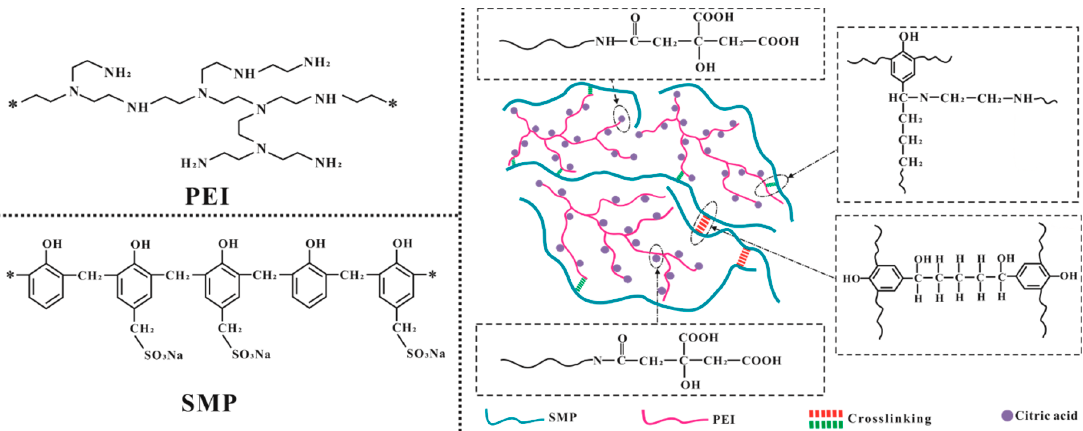
Figure 1. Molecular structure of polyethyleneimine (PEI), sulfonated phenolic resin (SMP) and the adsorbent (SPCT).